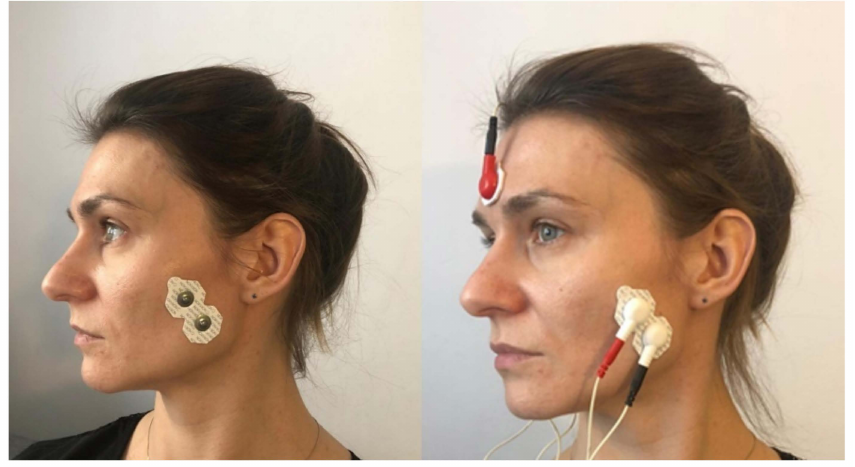
Figure 2. Location of surface electrodes on the masseter